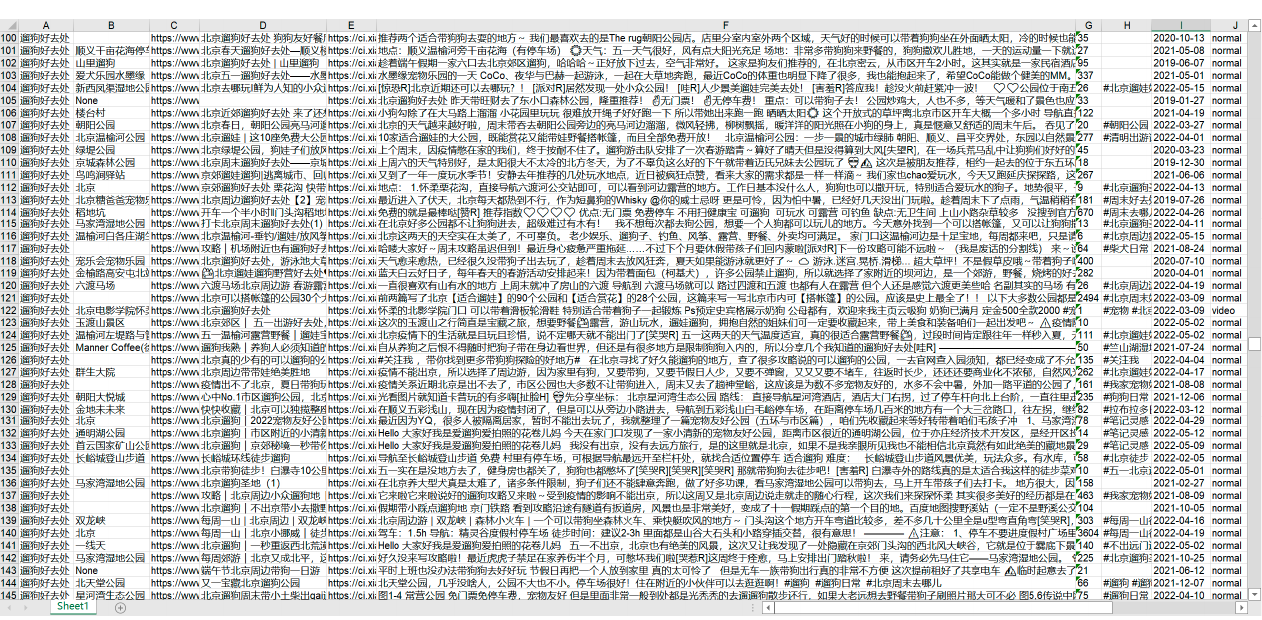
Figure A1. Some of the original text posted by Xiaohongshu users crawled using a web crawler.